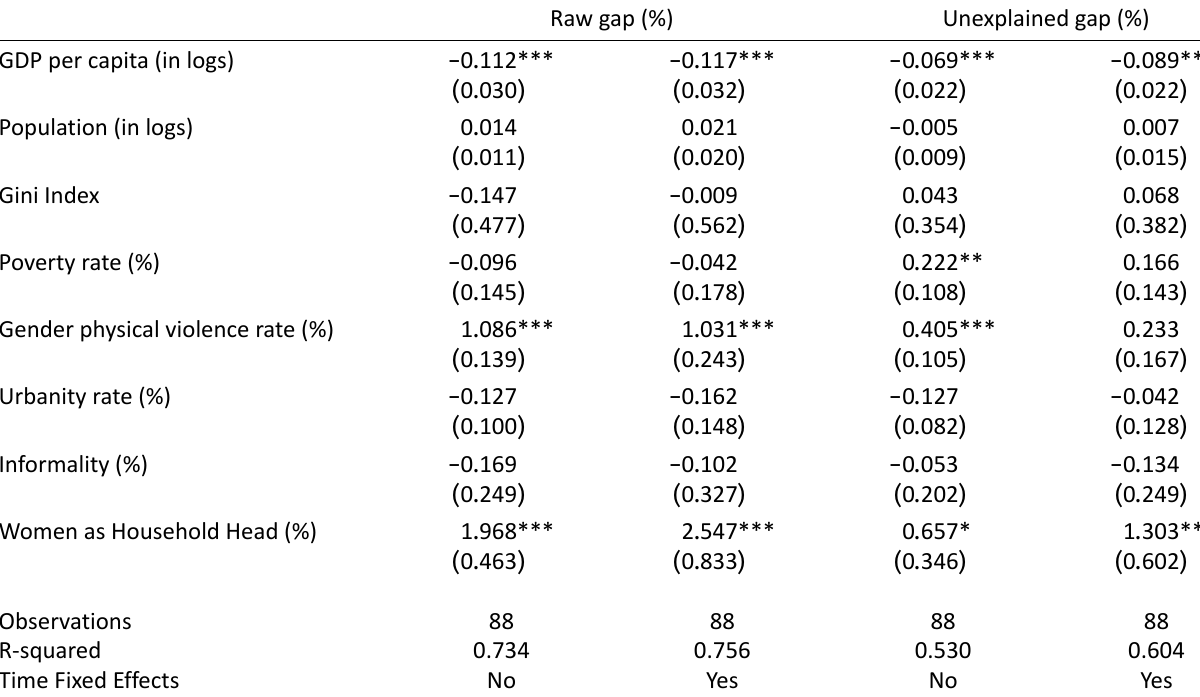
Table 8. Aggregate regional regressions.